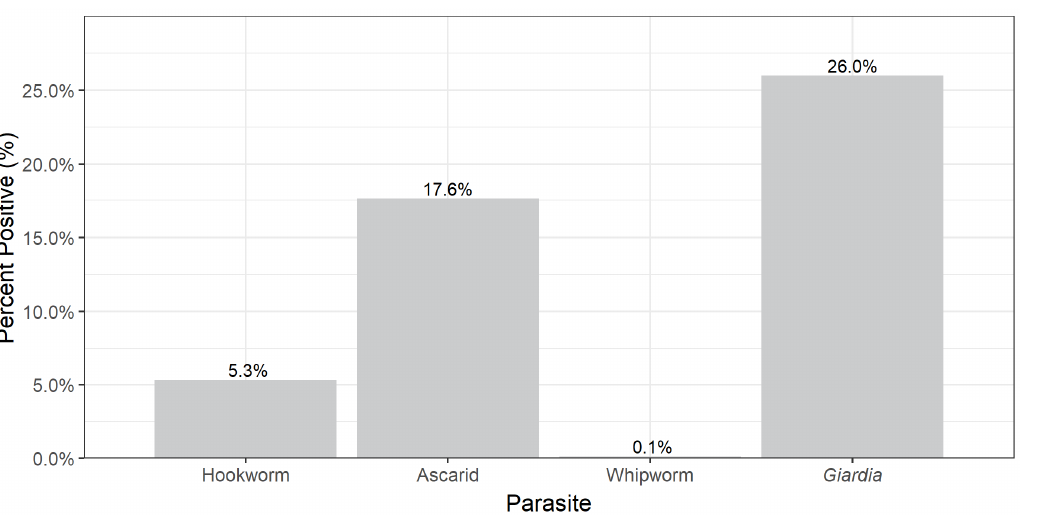
Table 2. Prevalence of parasites detected in the different life stages of dogs.